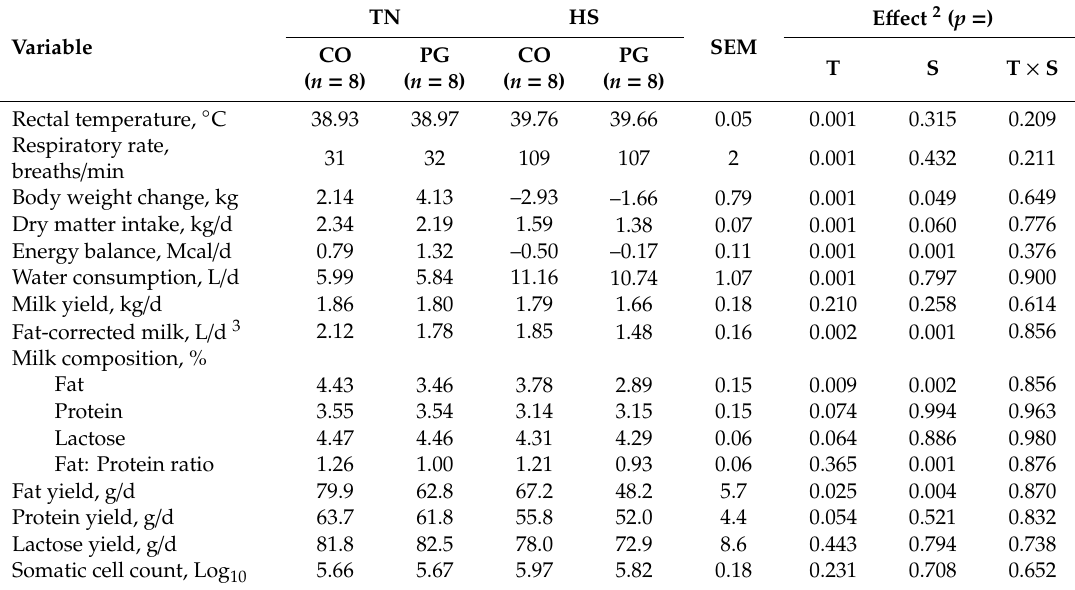
Table 2. Least squares means for physiological variables, feed intake, and milk production of dairy goats under thermoneutral (TN) and heat stress (HS) conditions. In each ambient temperature, goats were fed a control diet (CO) or supplemented with propylene glycol (PG).